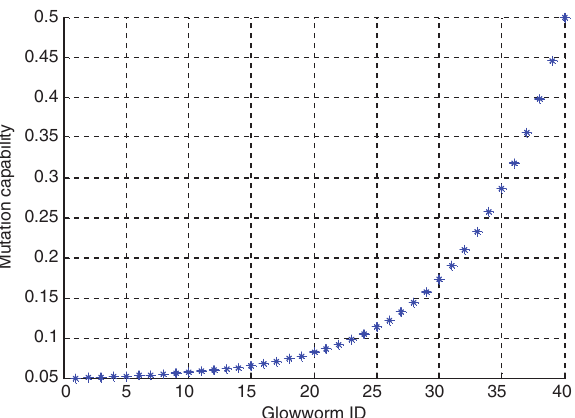
Figure 3. Individual Mutation Capability Curve.